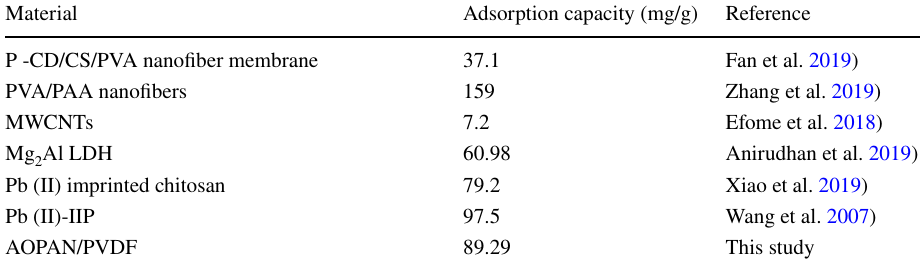
Table 5 Comparison to other materials for Pb 2 +